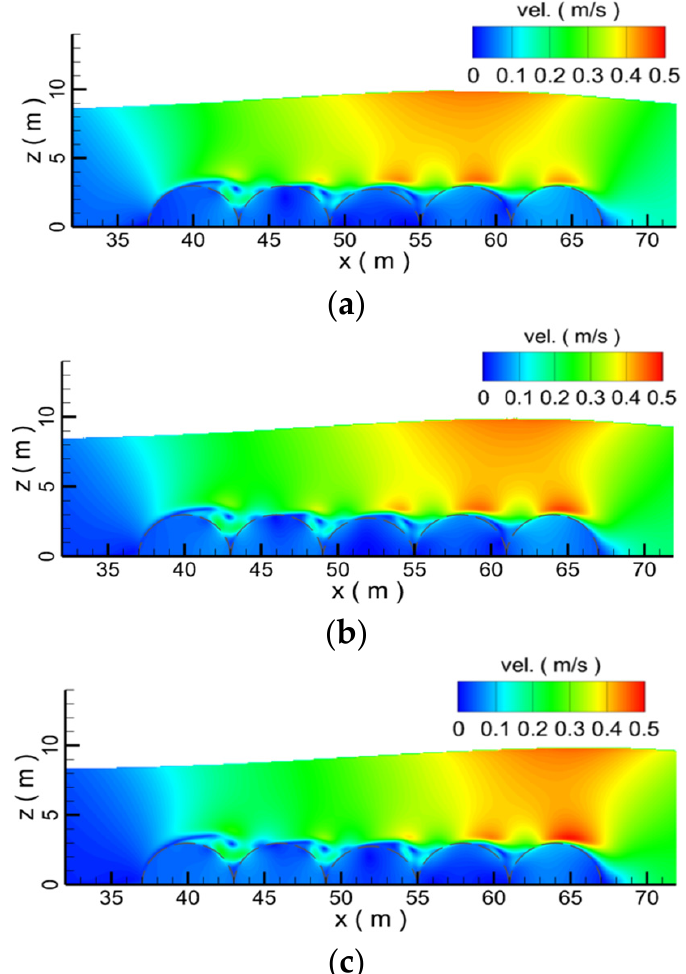
Figure 6. Maximum velocity on the fourth and fifth breakwater; ( a ) t = 12.4 s; ( b ) t = 12.8 s; ( c ) t = 13.2 s .